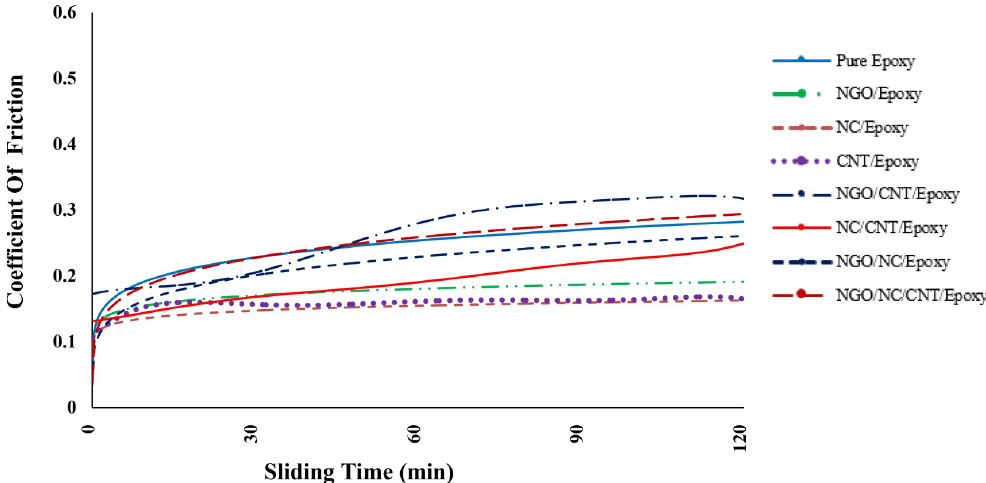
Fig 3. Variation of the coefficient of friction ( μ ) with sliding